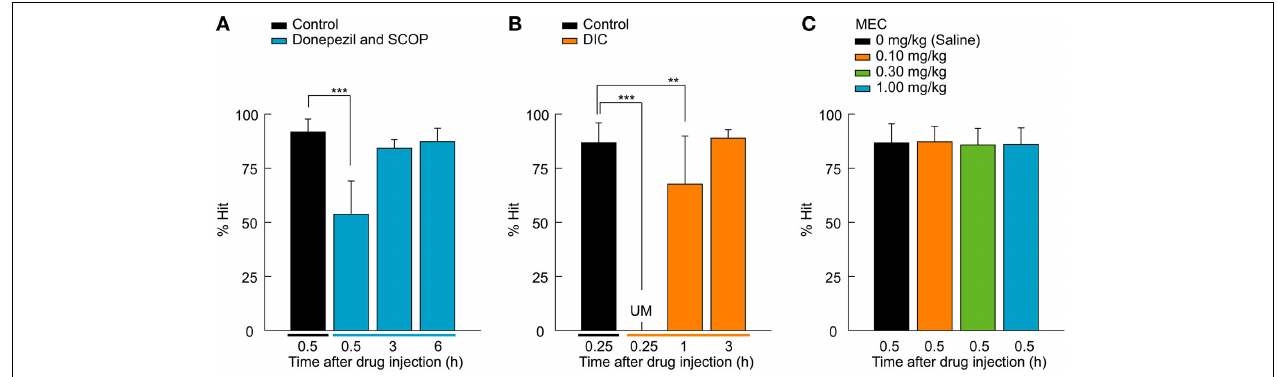
FIGURE 3 | M1 AChR-mediated retrieval function of the 2AFC task. (A) A cholinesterase inhibitor, donepezil (1.0mg/kg), was systemically administered to rats a half-hour before SCOP injection (0.30mg/kg). Donepezil attenuated the effect of SCOP on the performance of the 2AFC task, as rats were able to recall the association between lever-manipulation and reward even 0.5h after the SCOP injection and